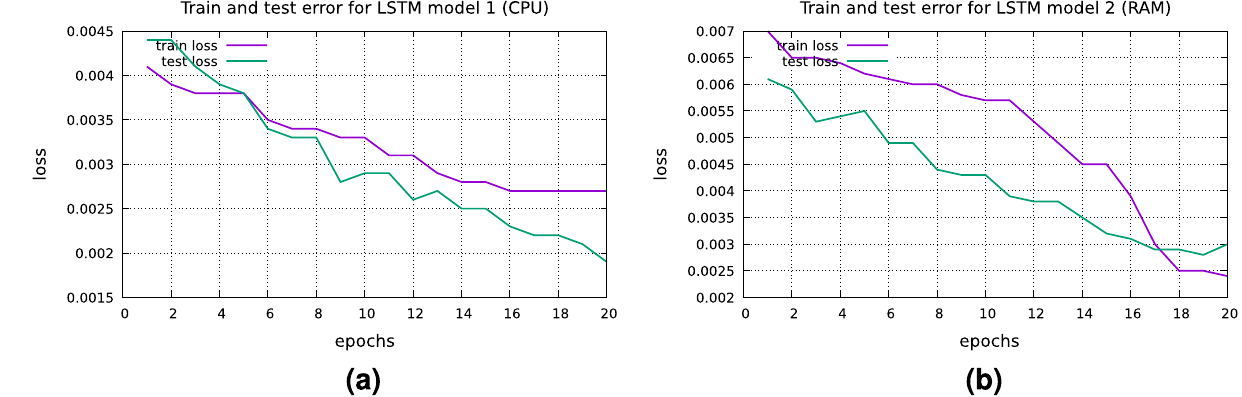
Figure 3. ( a ) Train and test error for LSTM model 1 (CPU) and ( b ) Train and test error for LSTM model 2